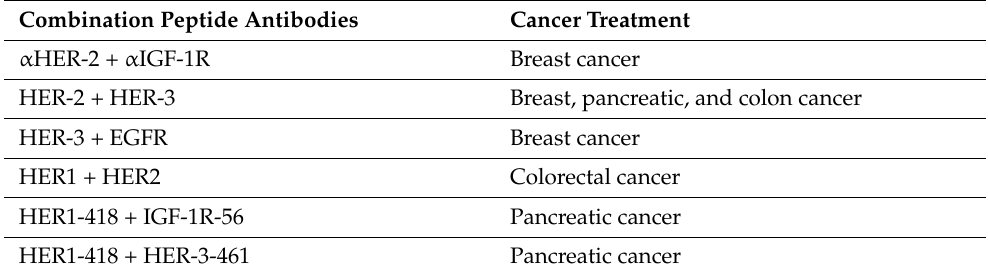
Table 2. Combined usage of peptide antibodies in cancer